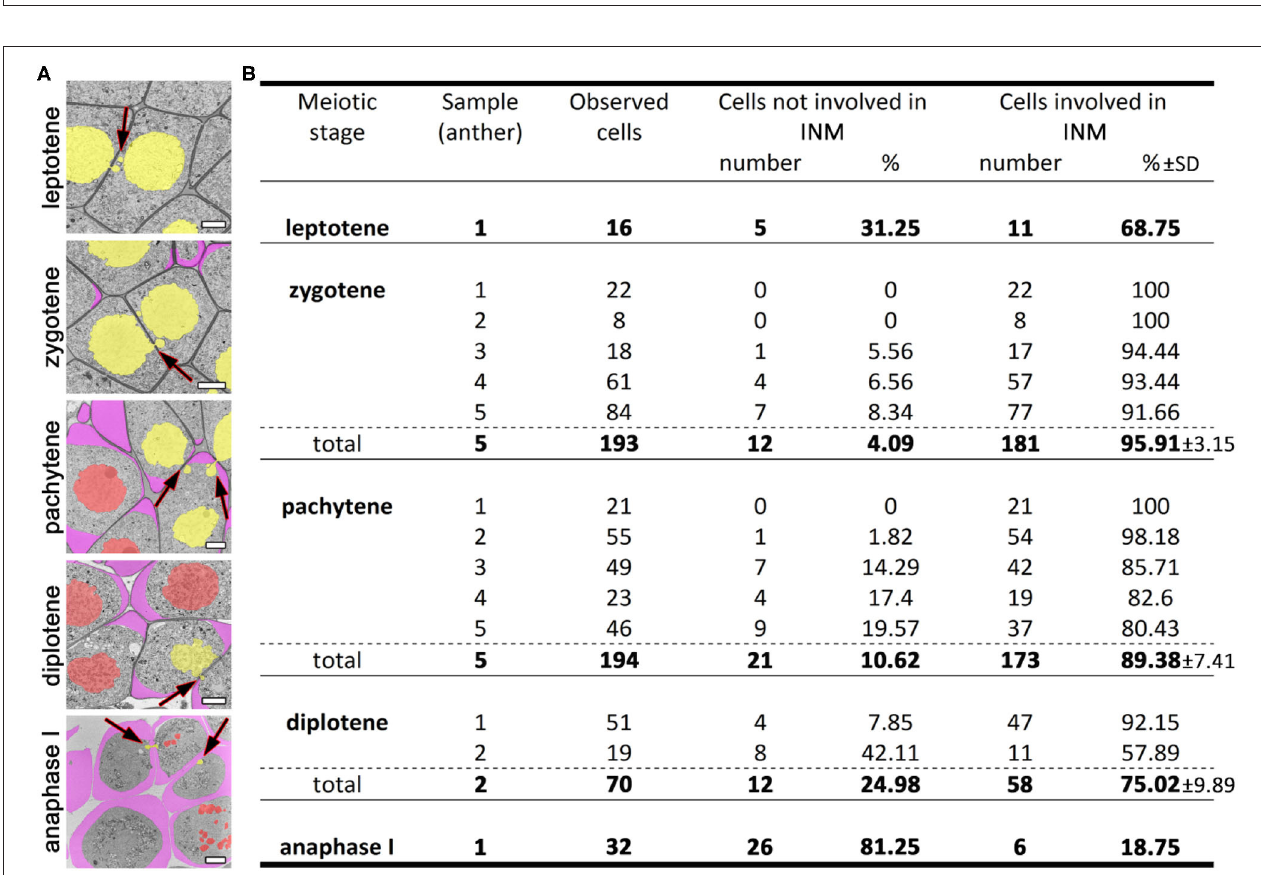
FIGURE 1 | tissue fragment (D) and labeled nuclei and cell walls (E) . Yellow denotes migrating nuclei, red non-migrating nuclei, blue partially scanned nuclei (their status is not clear), and turquoise the outer layer of cell walls, labeled on every 50th slice. The arrows point to the NPs crossing a cell wall. Scale bars are 5mm and 50 µ m in (A) and 5 µ m in (C) .